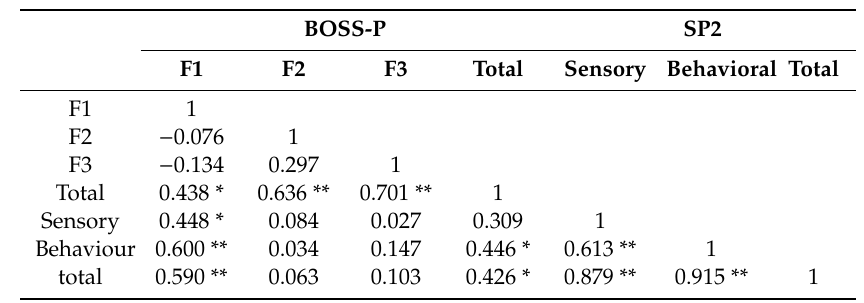
Table 3. Correlation matrix between the Behavioral Observation on Sensory Stimuli Questionnaire for Parents (BOSS-P) and the Short Sensory Profile 2 (SP2).